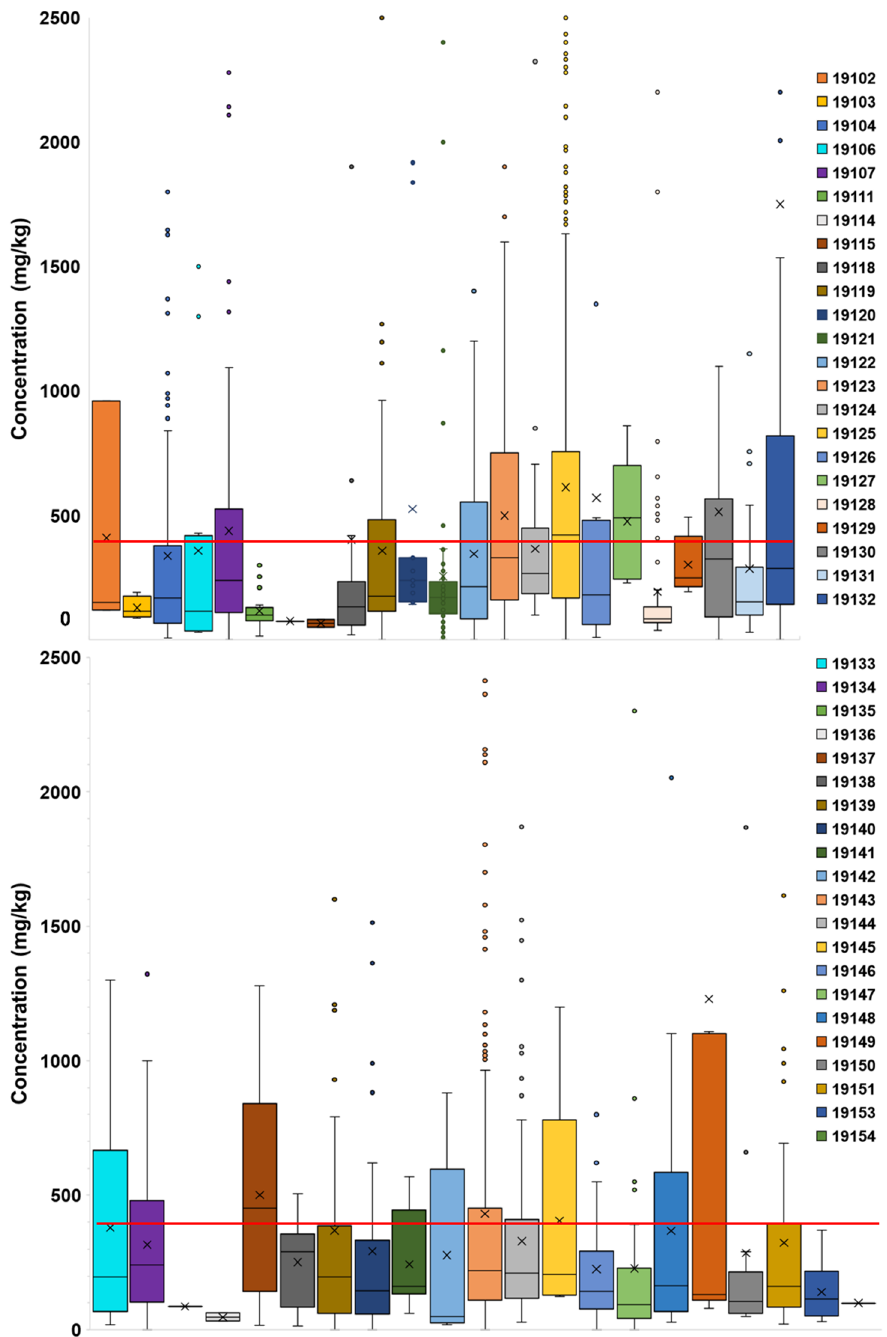
Figure 5. Box and whiskers plots of measured Pb-in-soil contents by ZIP codes in Philadelphia. The box shows the 25–75th percentile, the x is mean content, and the black line is median. Outliers are shown as dots. All graphs were clipped at 2500 mg/kg Pb, excluding outlier points in ZIP codes 19104, 19118, 19125, 19126, 19130, 19131, 19132, 19139, 19143, 19149, and 19151. The red horizontal line denotes the EPA threshold of 400 mg/kg Pb.